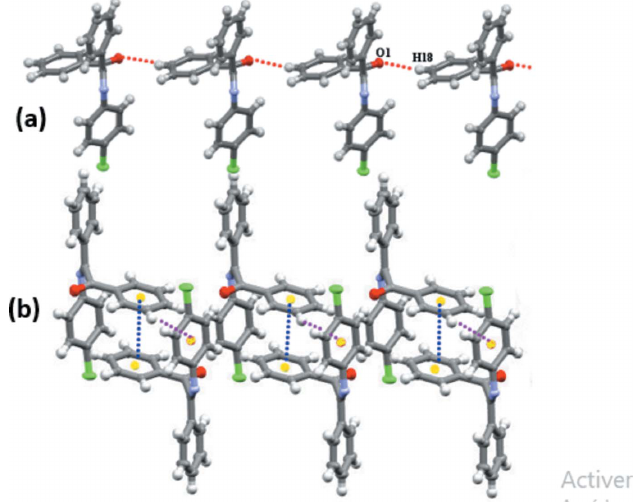
[Fig. 3( b )]. Along the c- axis direction, weak C—H (cid:3) (cid:3) (cid:3) (cid:2) (ring) interactions occur.